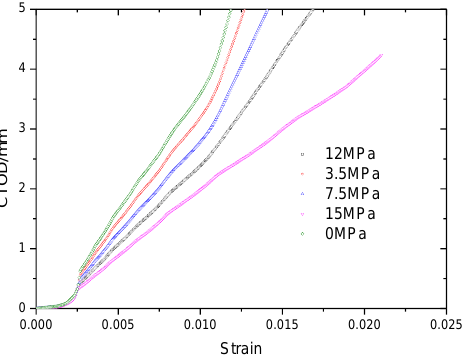
Figure 15. Crack growth driving force curves with different external pressure with a crack depth of 13 mm based on FEA results.